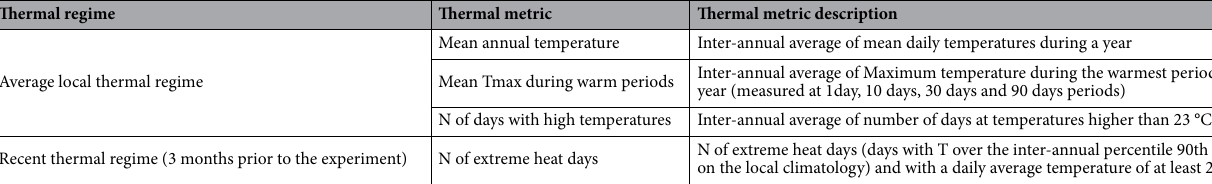
Table 2. Description of the thermal metrics used to compare thermal